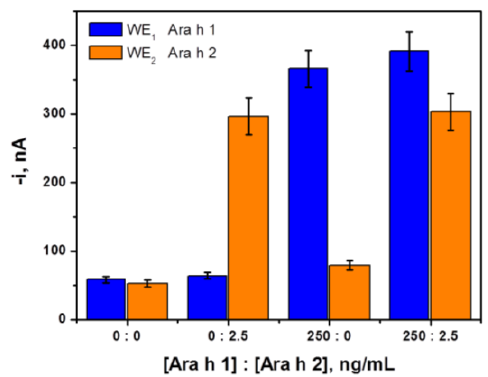
Figure 2. Simultaneous amperometric responses measured with the dual magnetic beads (MBs)-based immunosensor for mixtures containing: 0 ng/mL of both proteins; 0 ng/mL Ara h 1 and 2.5 ng/mL Ara h 2; 250 ng/mL Ara h 1 and 0 ng/mL Ara h 2; 250 ng/mL Ara h 1 and 2.5 ng/mL Ara h 2. E app = −0.20 V vs. Ag pseudo-reference electrode. Error bars estimated as triple the standard deviation ( n = 3).